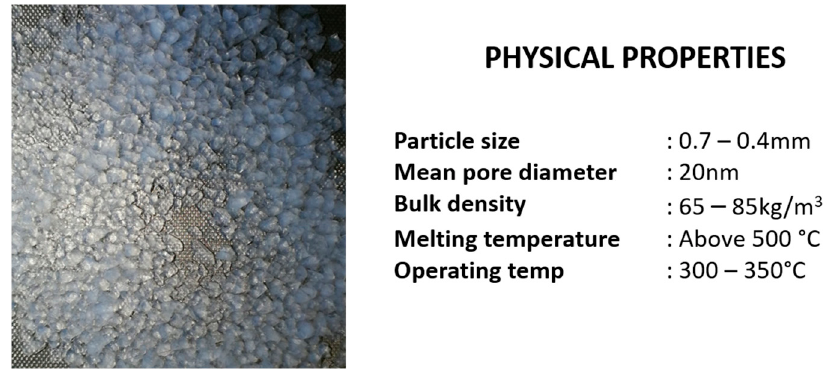
Figure 8. Silica aerogel granules used for composites fabrication and its physical properties.